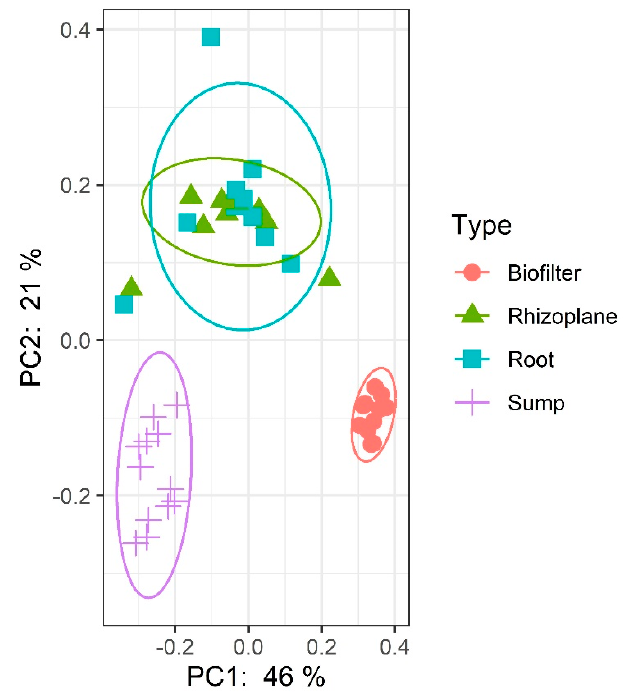
Figure 3. Weighted UNIFRAC Principal Coordinates Analysis representing the grouping of samples per compartment. Table 1. Observed-otus and Shannon indices for each